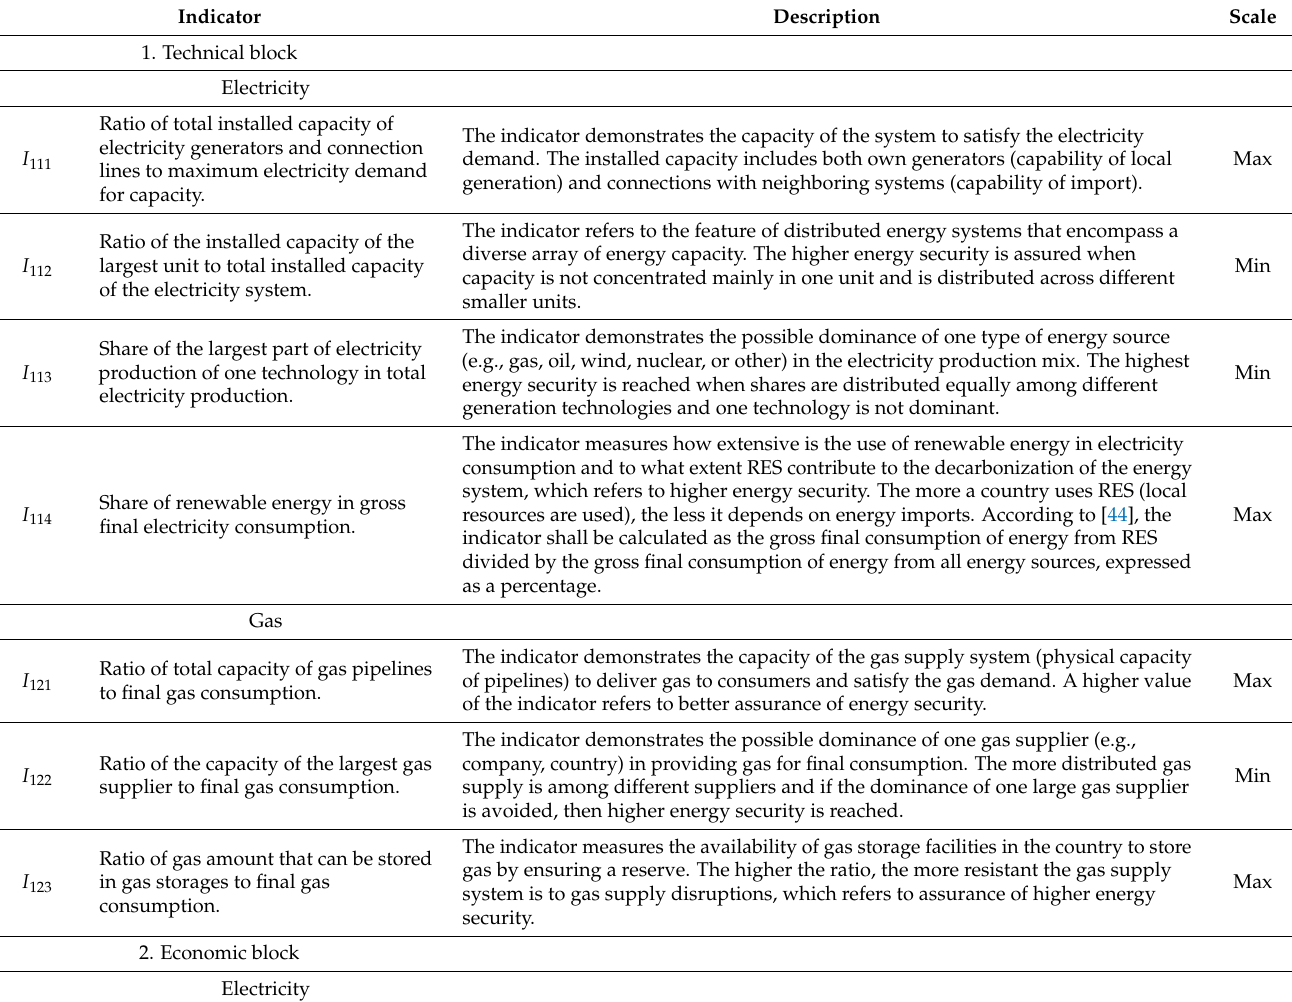
Table 4. System of Table 4. System of indicators.